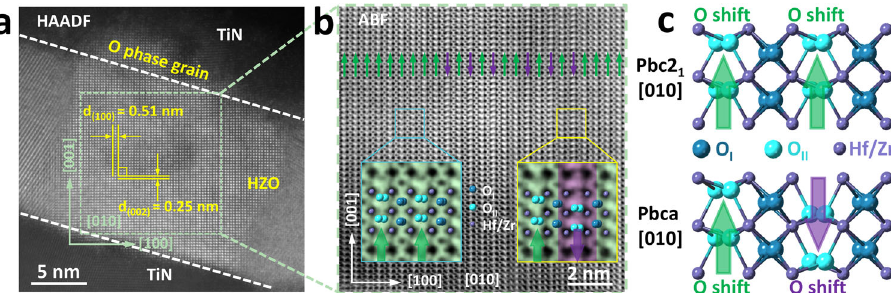
Fig. 1 The observation of oxygen atoms of single orthorhombic (O-) phase grain in pristine TiN/Hf 0.5 Zr 0.5 O 2 (HZO, 15 nm)/TiN device. a Scanning transmission electron microscopy (STEM) high-angle annular dark- fi eld (HAADF) image of the TiN/HZO/TiN cross-section. b Annular bright- fi eld (ABF) image extracted from the green square area in a , in which the position of the O atomic columns can be clearly detected with different offset and direction. According to the O atomic columns deviated from the center of the four nearest Hf/Zr columns, it can be divided into O I type (center) and O II type (off- center). Some of the O II -site columns shift along the [001], while others shift to the opposite direction. c The atomic models of the Pbc 2 1 and Pbca phases along [010] direction. The purple, navy blue, and cyan-colored solid balls correspond to the Hf/Zr, O I (center), and O II (off-center) ions,